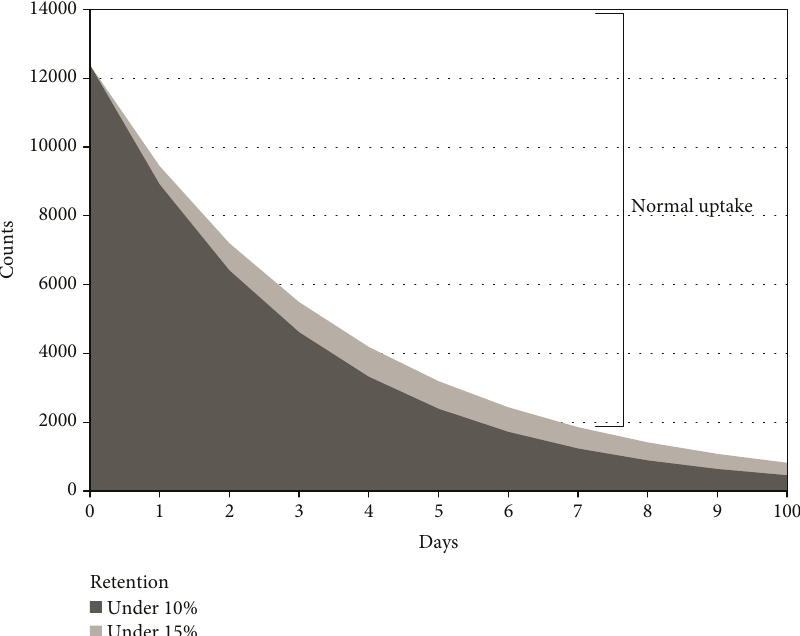
Figure 4: The lines show the threshold levels of the normal uptake value of SeHCAT from day 0 to day 10 evaluated for retention of 10% and 15% at day